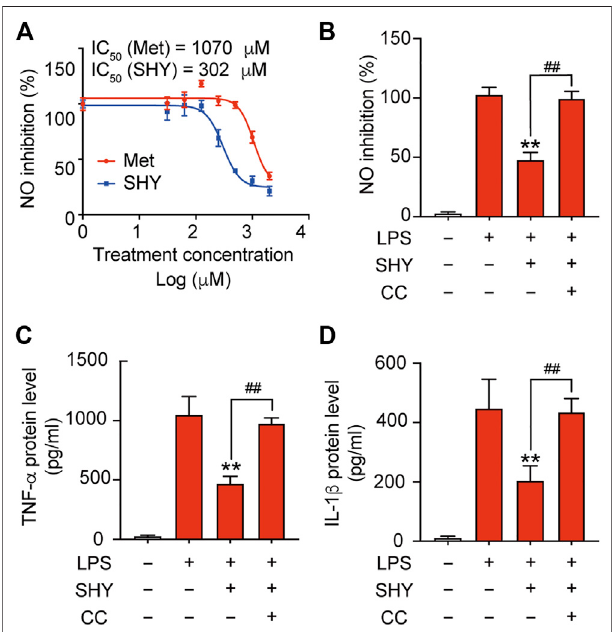
FIGURE 2 | SHY-01 inhibits LPS-induced in fl ammation through AMPK activation. (A) BV-2 microglial cells were pre-incubated with seven different concentrations of SHY-01 (SHY, 0.03 – 2.0 mM) or metformin hydrochloride (Met) for 1 h, followed by LPS treatment for another 24 h. Supernatants were collected for nitrite analysis. Nonlinear regression was fi t to the inhibition ofSHY(blueline)andMet(redline). (B) PercentageofNOinhibition, (C) TNF- α protein level and (D) IL-1 β protein level in the supernatant of BV-2 microglia cells pre-incubated with AMPK inhibitor (Compound C, CC, 10 μ M) for 1 h followed by SHY-01 (SHY, 1 mM) and LPS (200 ng/ml) administration. Data were expressed as mean ± SD ( n = 3) and analyzed using one-way